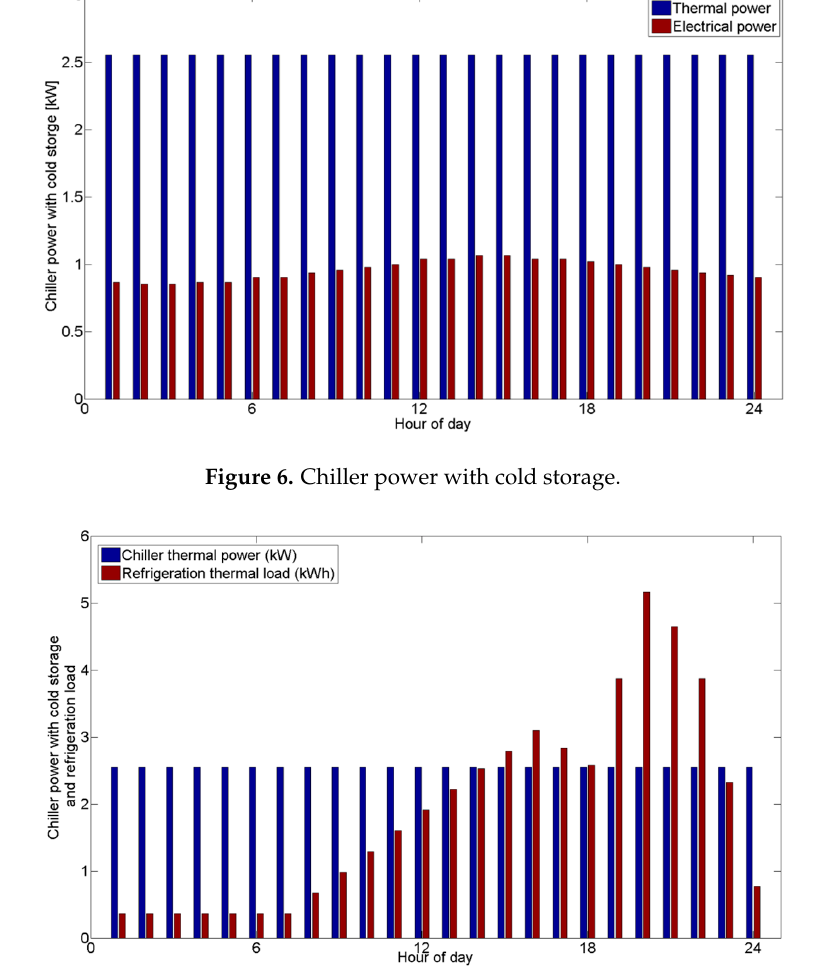
Figure 7. Chiller thermal power and refrigeration loads.